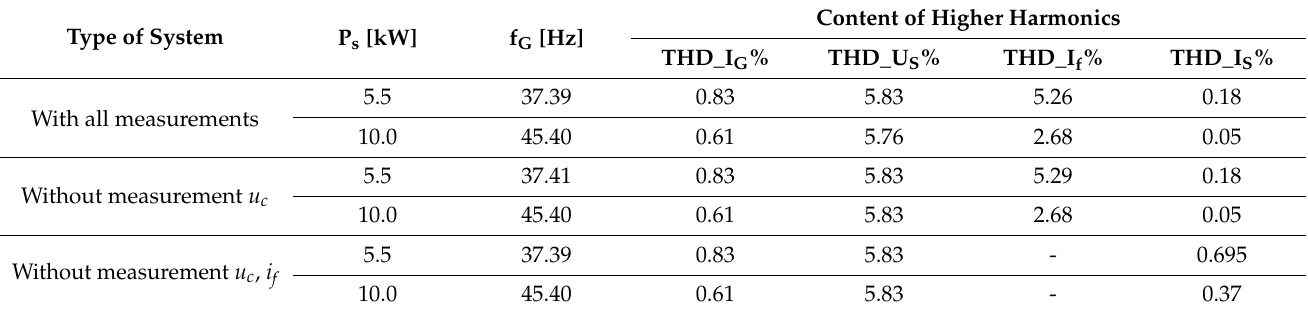
Table 1. The content of higher harmonics.